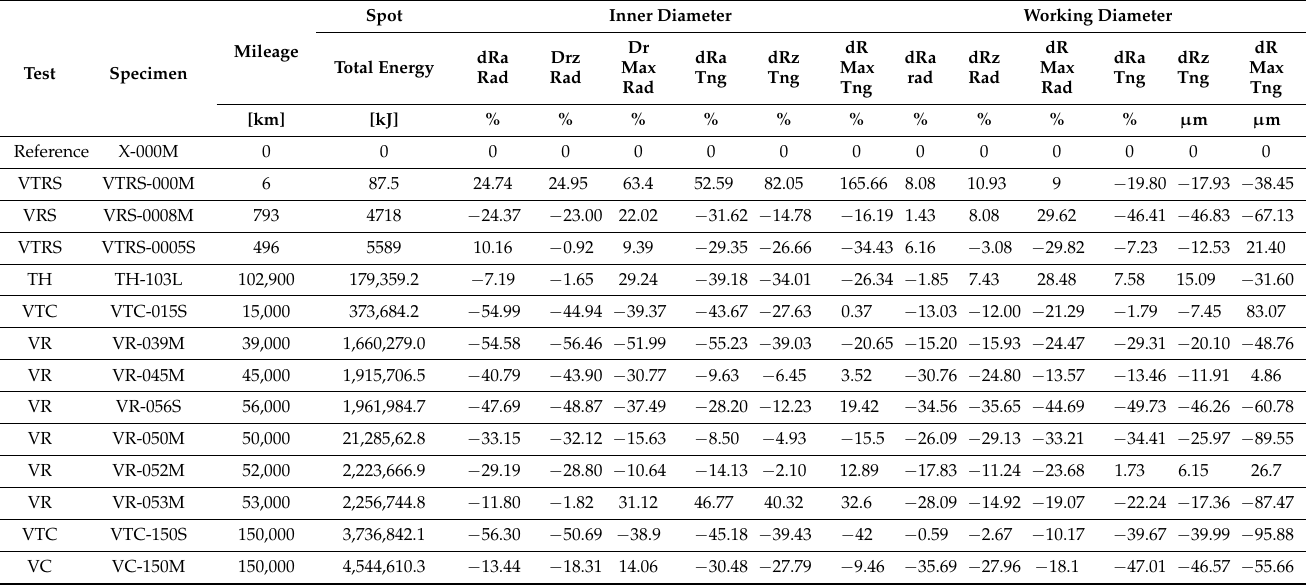
Table A6. Deviation of tested surface roughness values of facings from the initial surface roughness